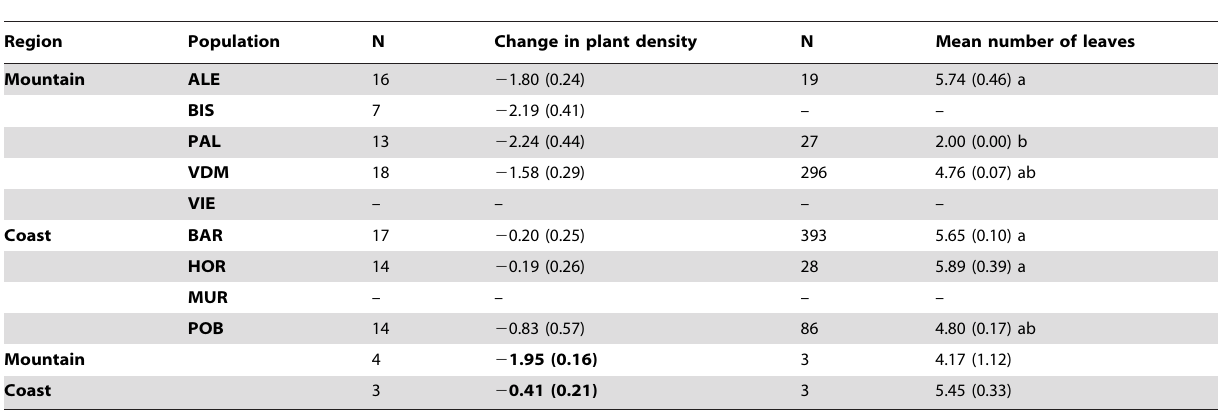
Table 2. Sample size and mean ( 6 SE) values for change in plant density and mean number of leaves of A. thaliana .